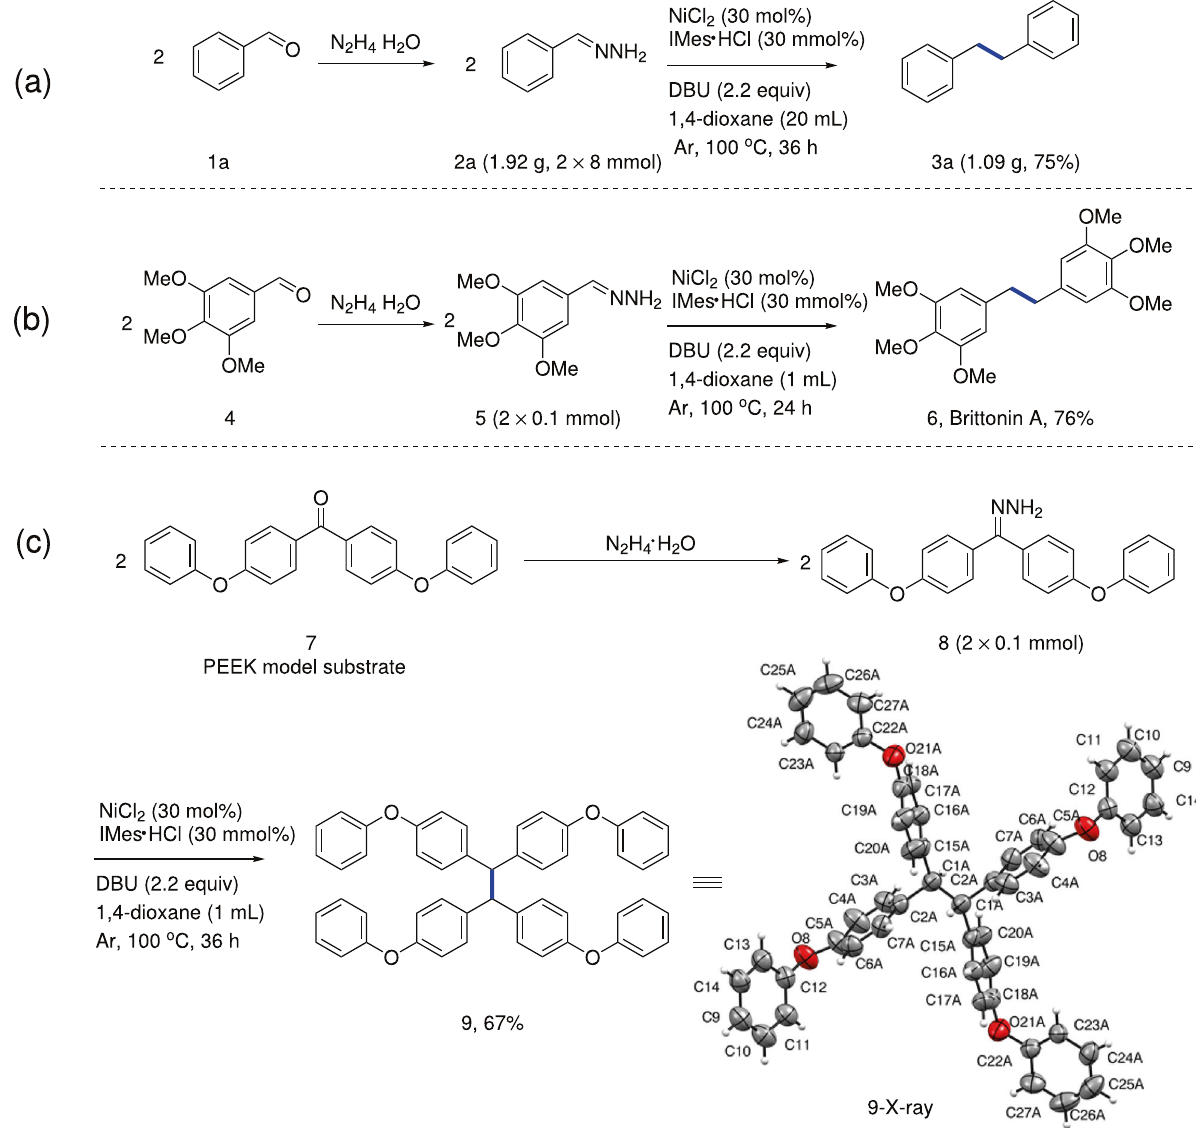
Fig. 3 Applications of the deoxygenative aldehyde/ketone homo-coupling. a Gram-scale experiment. b Synthesis of Britonin A. c Conversion of polyetheretherketone (PEEK)